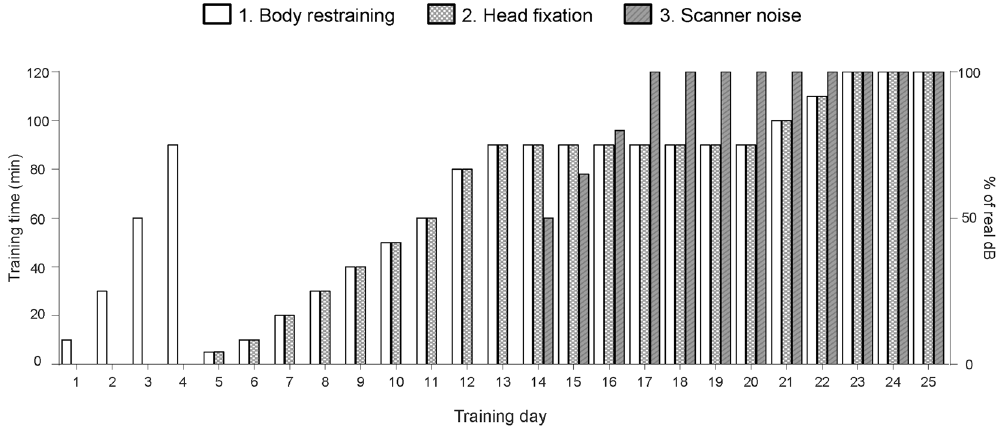
Figure 1. Schematic representation of the acclimation